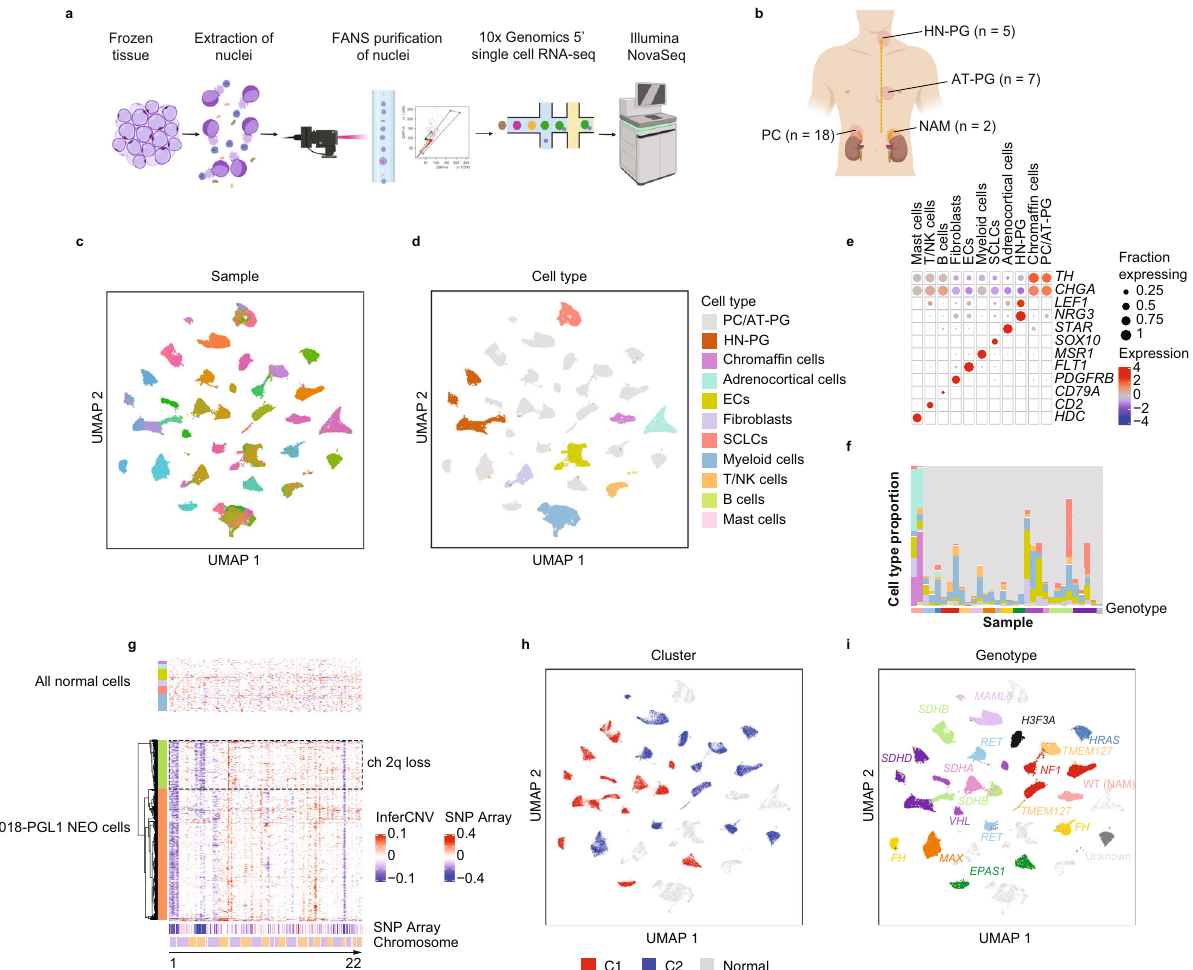
Fig. 1 | snRNA-seq for cell type identi fi cation, inferred copy-number analysis and clustering of 30 PCPG and two NAM tissues. a Schematic describing the work fl ow for single-nuclei isolation, Fluorescence-Activated Nuclei Sorting (FANS) and 5 ’ chemistry using the 10x platform starting from frozen tissues (created with BioRender.com). b Anatomical locations and sample size of tumors pro fi led with snRNA-seq (created with BioRender.com). c UMAP clustering of all nuclei from all samples colored by sample (individual color-sample key not shown, nSamples= 32). d UMAP clustering of all nuclei from all samples colored by cell type. ECs: Endothelial cells, SCLCs: Schwann cell-like cells. (nNuclei=109,238). e Expression of major cell type markers in annotated UMAP clusters. Expression scale=Z-score